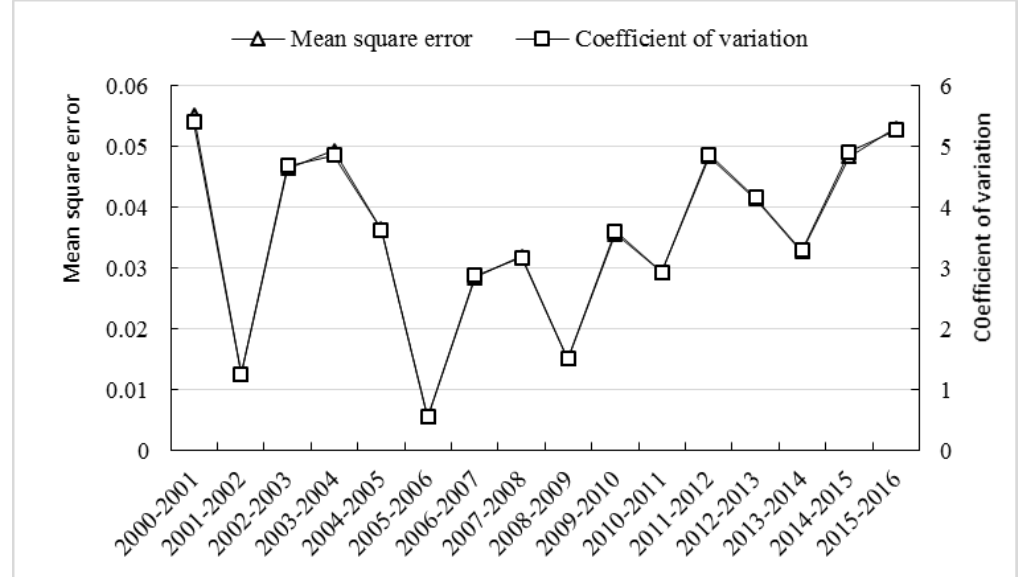
Figure 8. Changes in average variance and coefficient of variation of SEC.